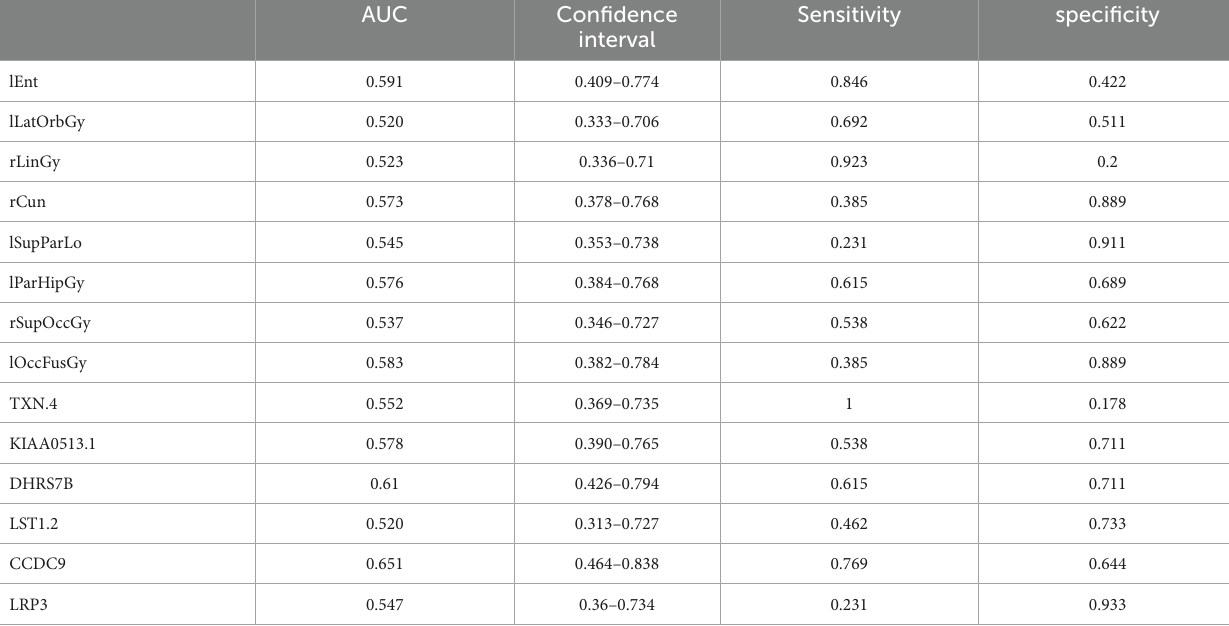
TABLE 9 ROC curve information of a single top features in the MCI group.